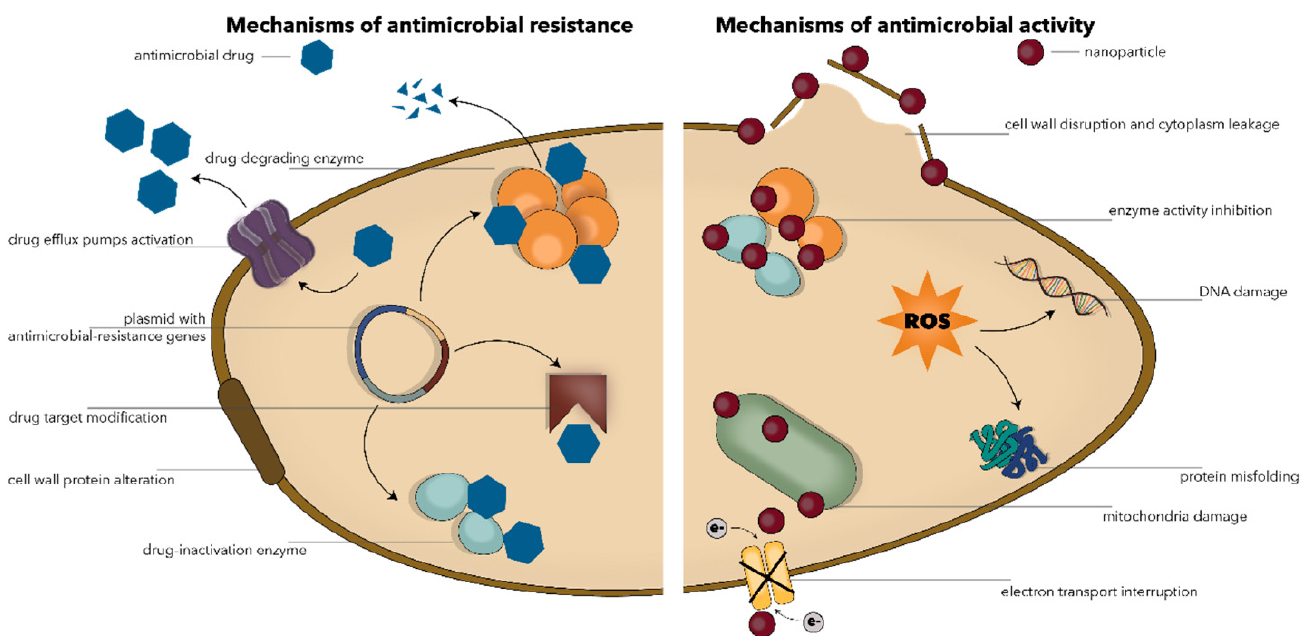
Figure 4. Visual representation of antimicrobial resistance mechanisms ( left ) and antimicrobial activity of nanoparticles ( right ). Reprinted from an open-access source [173]. Table 1. Polymer-based delivery nanosystems for antimicrobial drugs.